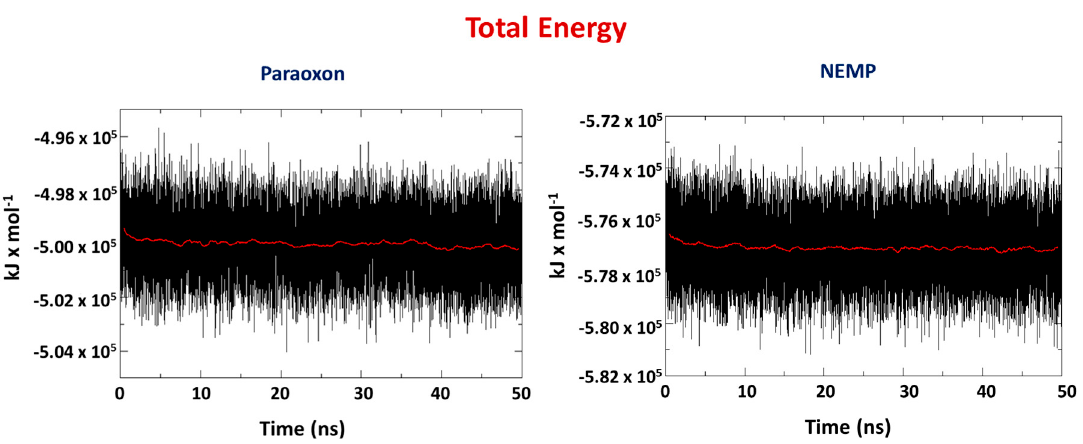
Figure 5. Total energy for the systems PTE/PXN and PTE/NEMP during 50 ns of molecular dynamics (MD) simulation.